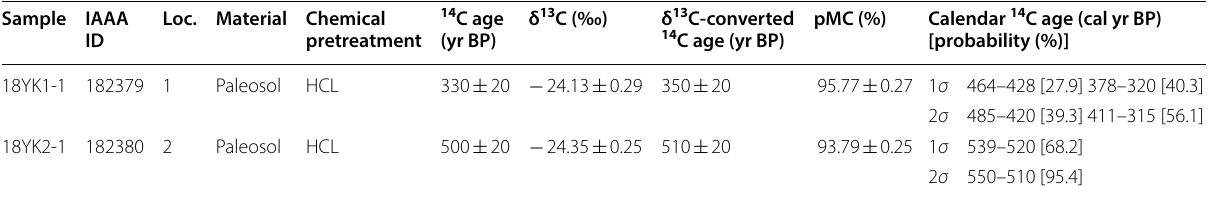
Calibrated ages were calculated using Intcal13 (Reimer et al. 2013). We adopted the 2 σ of calendar 14 C age